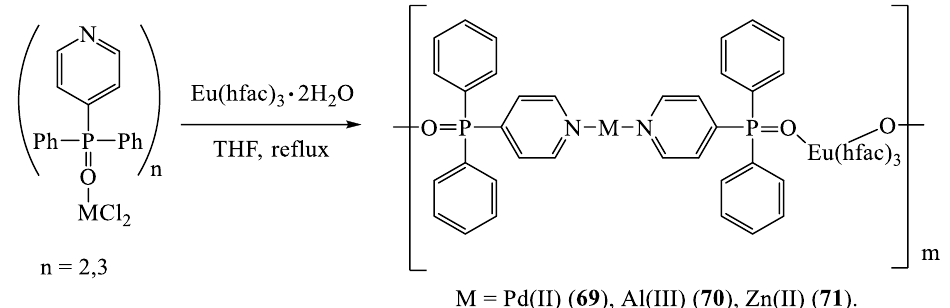
36 of 51 Figure 35. Molecular structure of 68 [108]. CF 3 groups are transparent for clarity. The cif has been retrieved from CCDC. CCDC number is 812496. Heterometallic polymer complexes 69 – 71 including Eu(III) tris - β -diketonate frag-